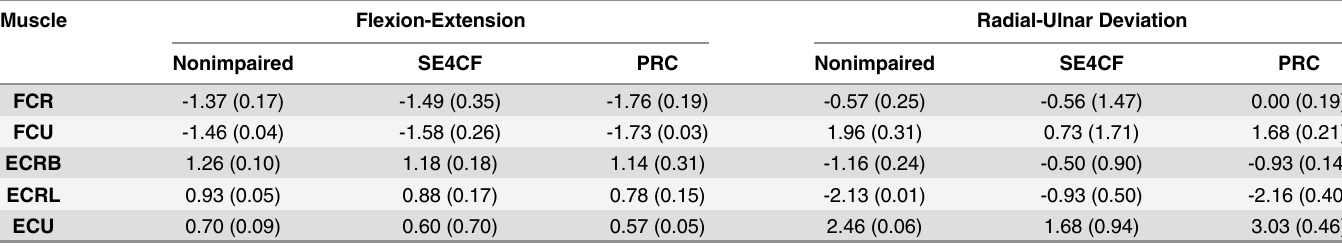
Table 1. Wrist Muscle Moment Arms Predicted by the Models # .